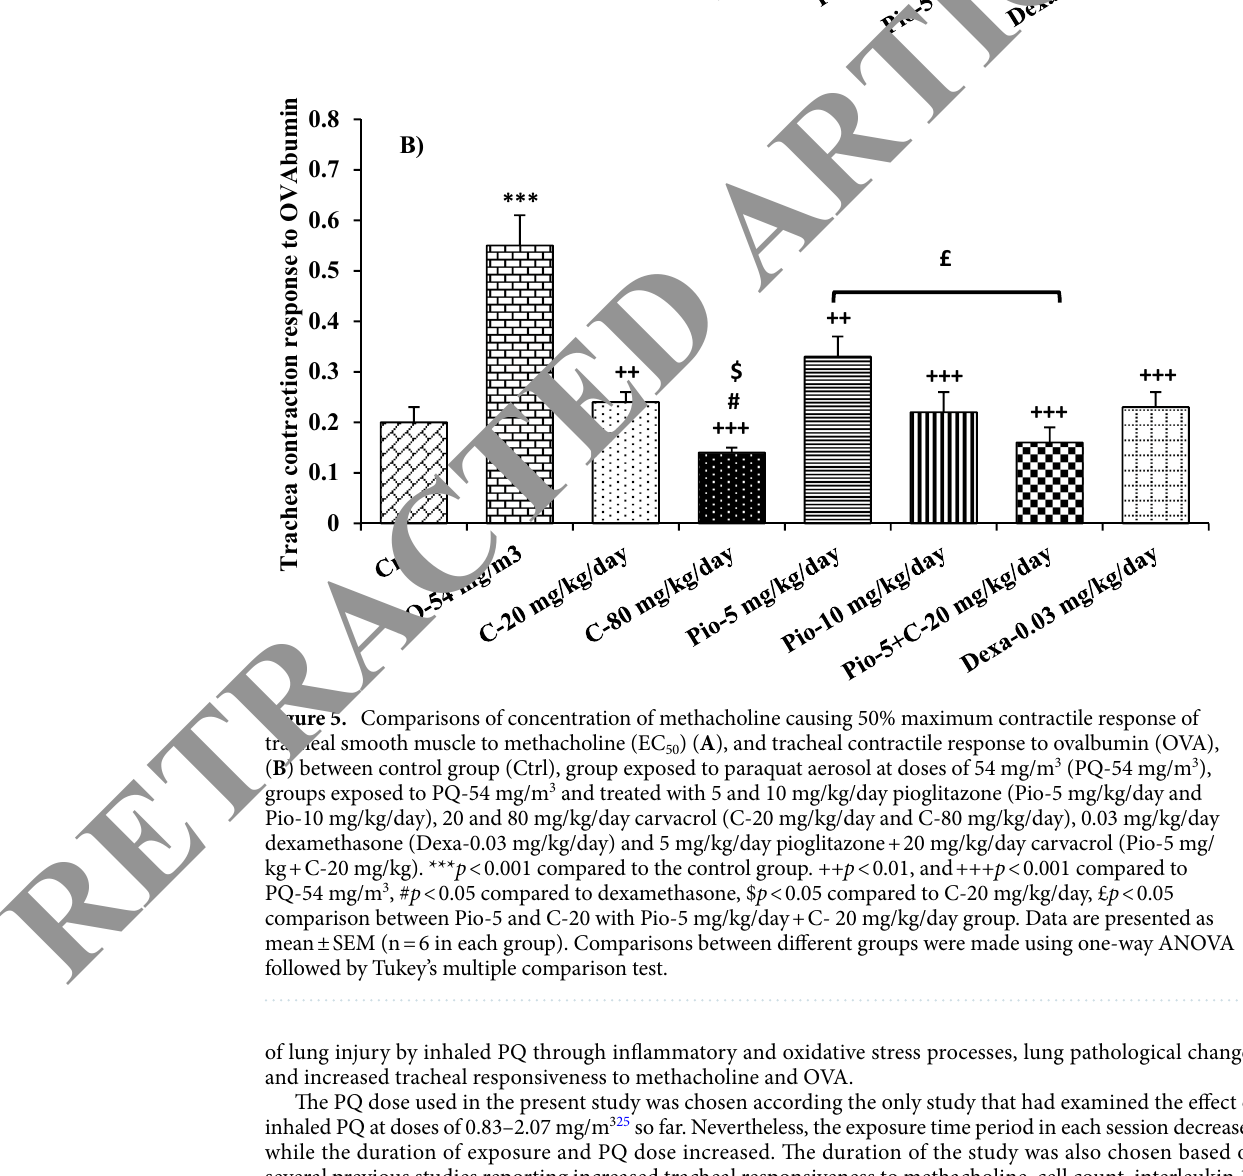
of lung injury by inhaled PQ through inflammatory and oxidative stress processes, lung pathological changes and increased tracheal responsiveness to methacholine and OVA. The PQ dose used in the present study was chosen according the only study that had examined the effect of inhaled PQ at doses of 0.83–2.07 mg/m 325 so far. Nevertheless, the exposure time period in each session decreased while the duration of exposure and PQ dose increased. The duration of the study was also chosen based on several previous studies reporting increased tracheal responsiveness to methacholine, cell count, interleukin 17 (IL-17), TGF-β levels in the BALF, and collagen deposition in the lung 15 days following PQ administration in